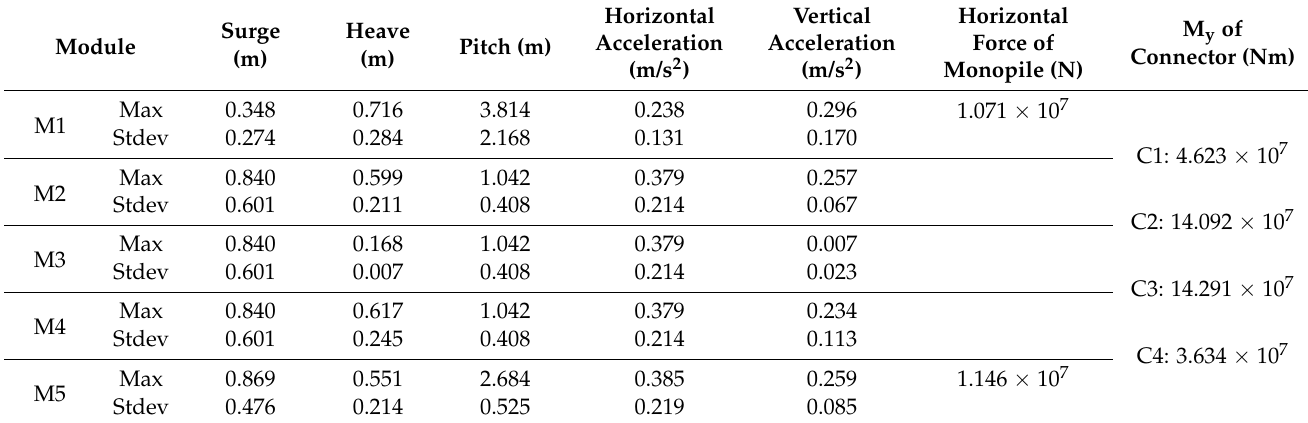
Table 4. Statistic information of main extreme responses of the MIFS